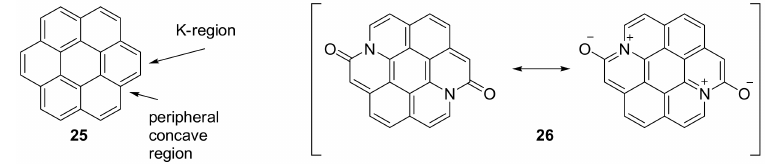
Figure 1. Structure of compound 26 and its limit